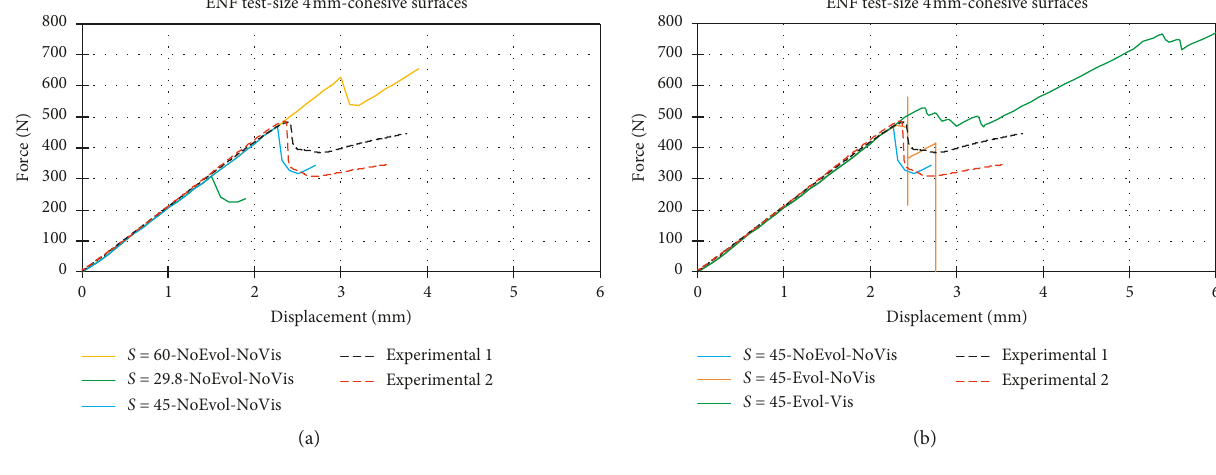
Figure 21: ENF test: cohesive surface approach (element size 4mm).